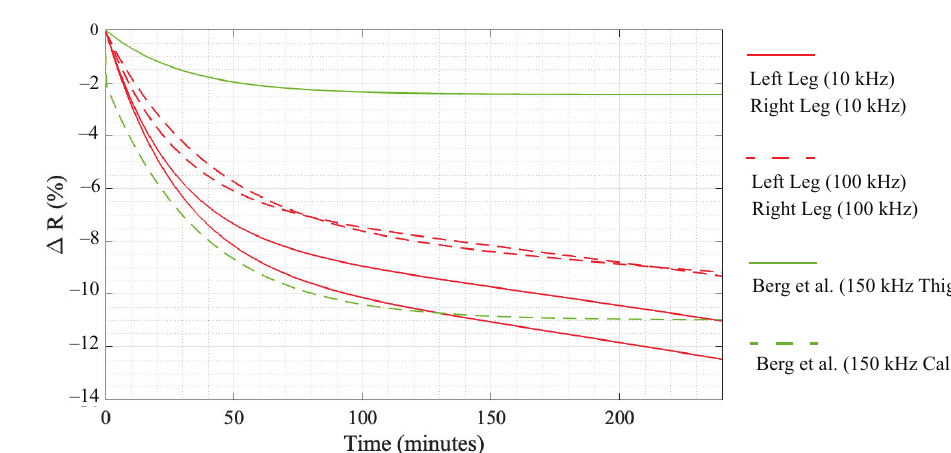
Figure 5. Comparison of the relative 10 and 100 kHz left and right resistance changes from study participants compared to the 150 kHz relative difference between the thigh and calf by Berg et al. [12].